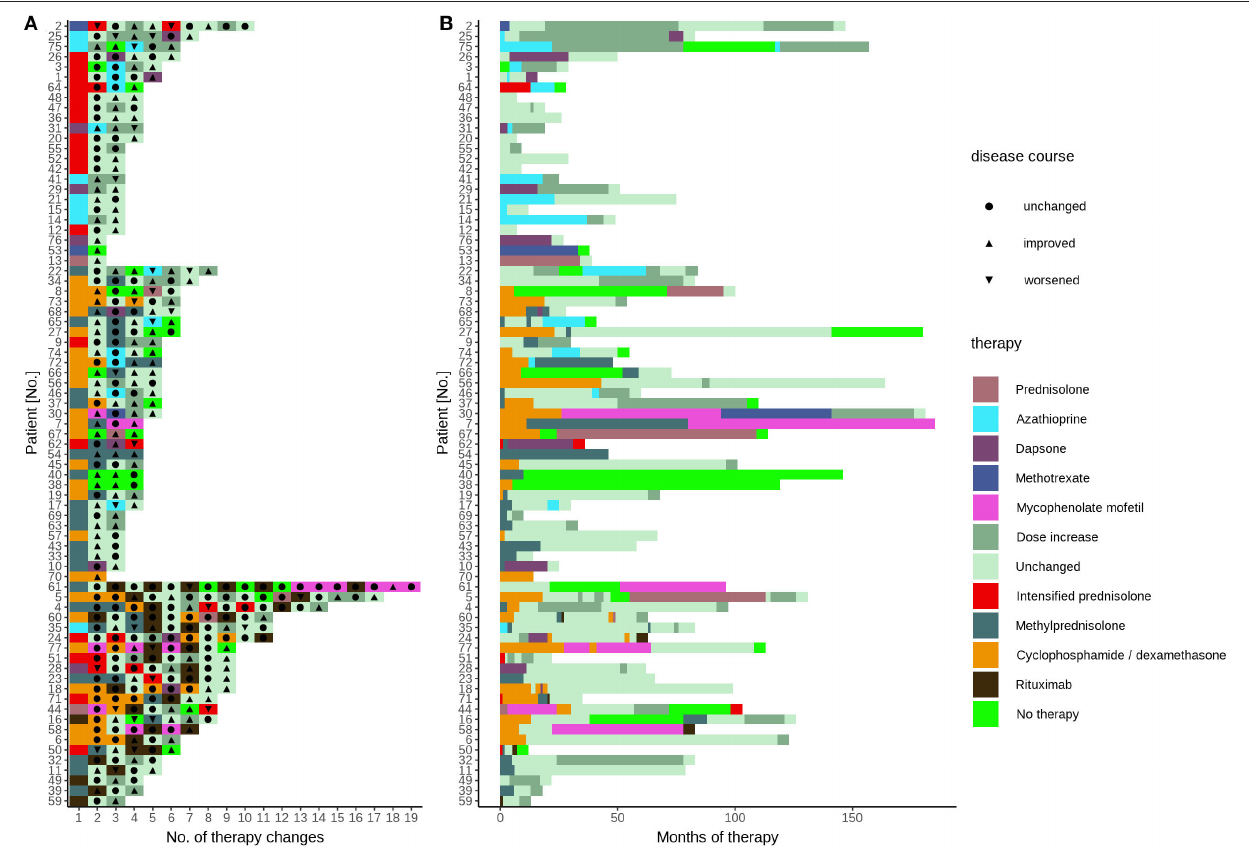
FIGURE 1 | Treatment sequelae of pemphigus patients. All specific treatments of pemphigus patient’s disease and treatment course in the patient cohort displayed according to (A) therapies grouped into oral systemic immunosuppressants (upper), pulse therapies (middle), and rituximab (lower) and (B) treatment duration. Each color represents the treatment after the last change or dose change. The conventional systemic therapies between pulse therapies or rituximab courses are not shown. The triangles and circles indicate clinical